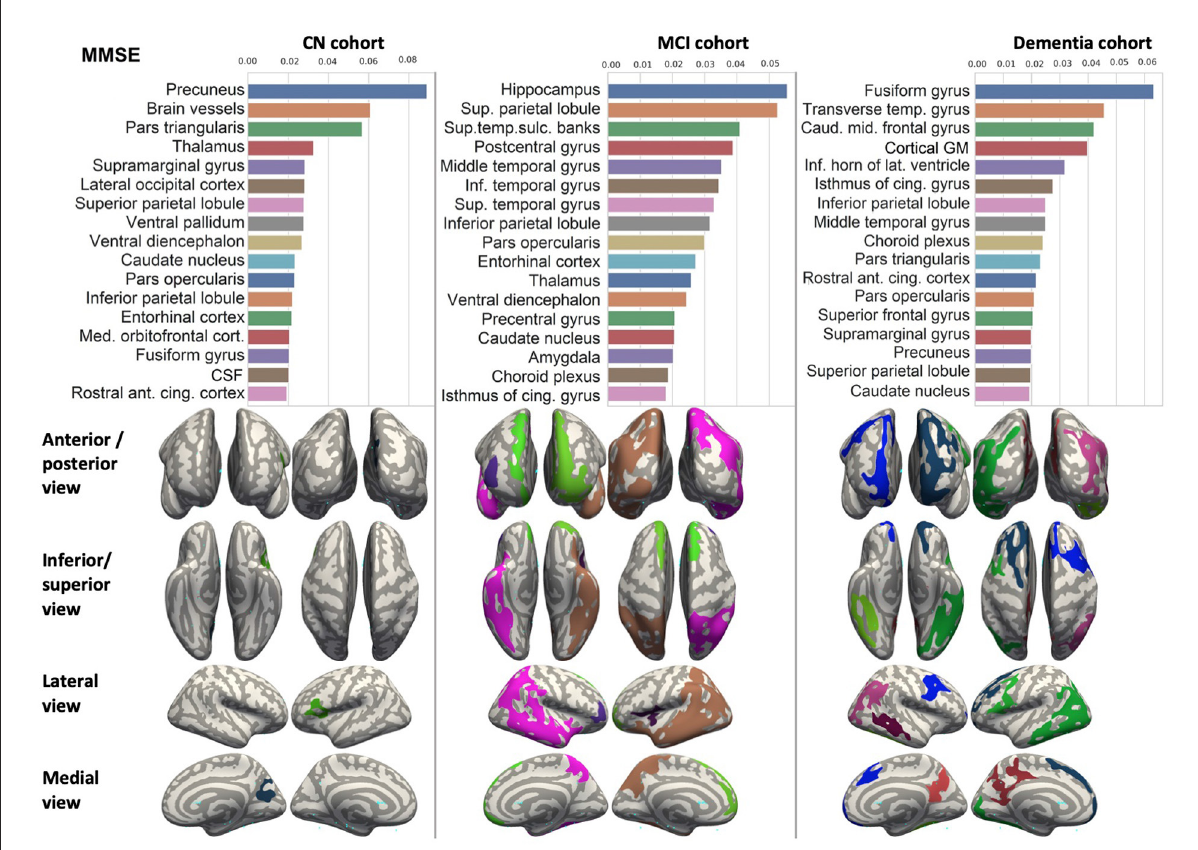
FIGURE3 Brain structures ranked according to information gain value for MMSE score prediction. Inflated cortical representations showing significant correlations between cortical volumes and test